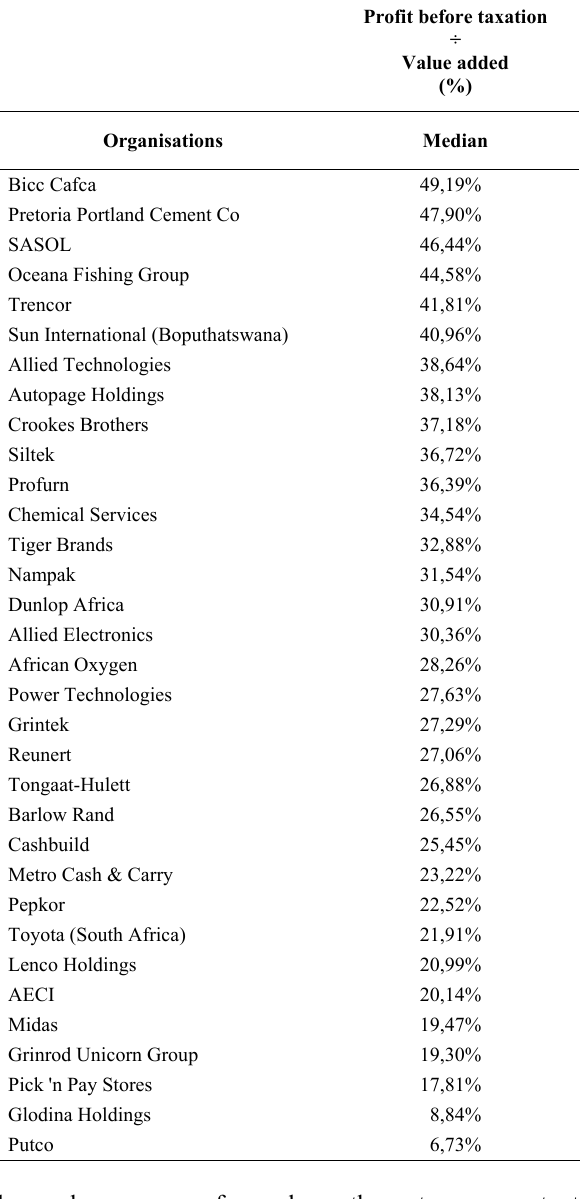
Table 7: Profit before taxation ÷ Value added